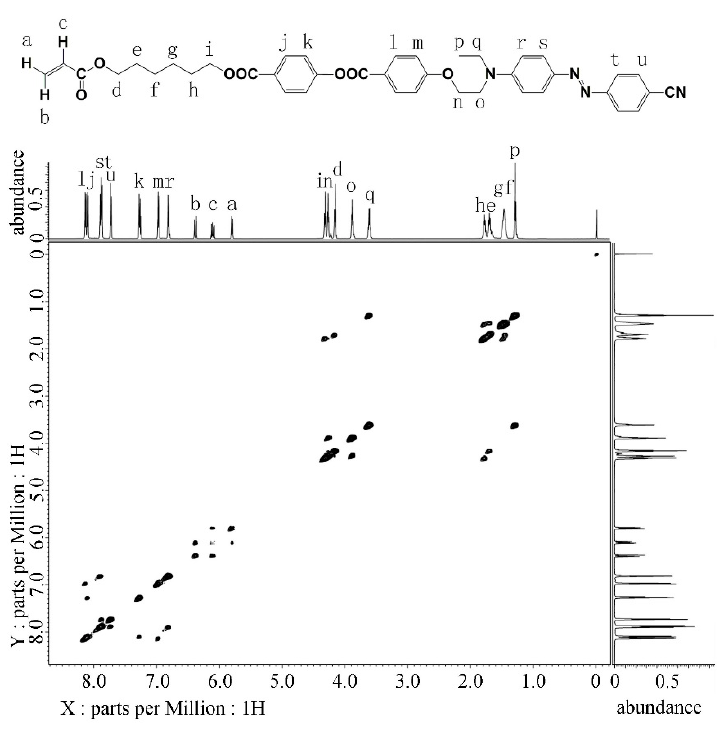
Figure 2. NMR COSY spectrum of 7B .